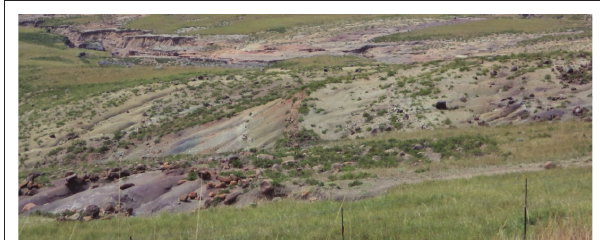
Source : Photo taken by Andries Jordaan. FIGURE 4: Soil erosion on sloped areas.